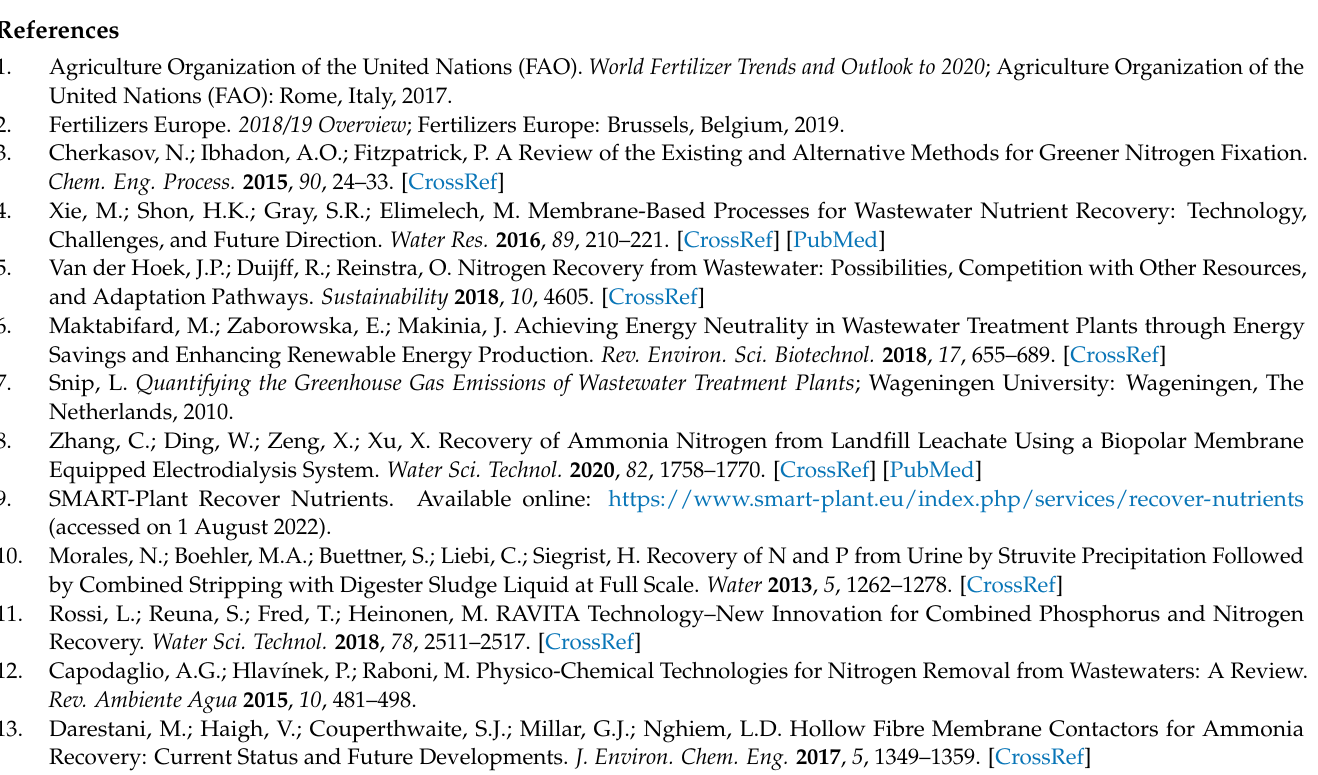
Figure S2: Effect of mixing on NH3 recovery. Figure S3: The effect of tannin coagulation and UV + H 2 O 2 cleaning on ammonia recovery from landfill leachate. Figure S4: EDS elemental percentage of (a)